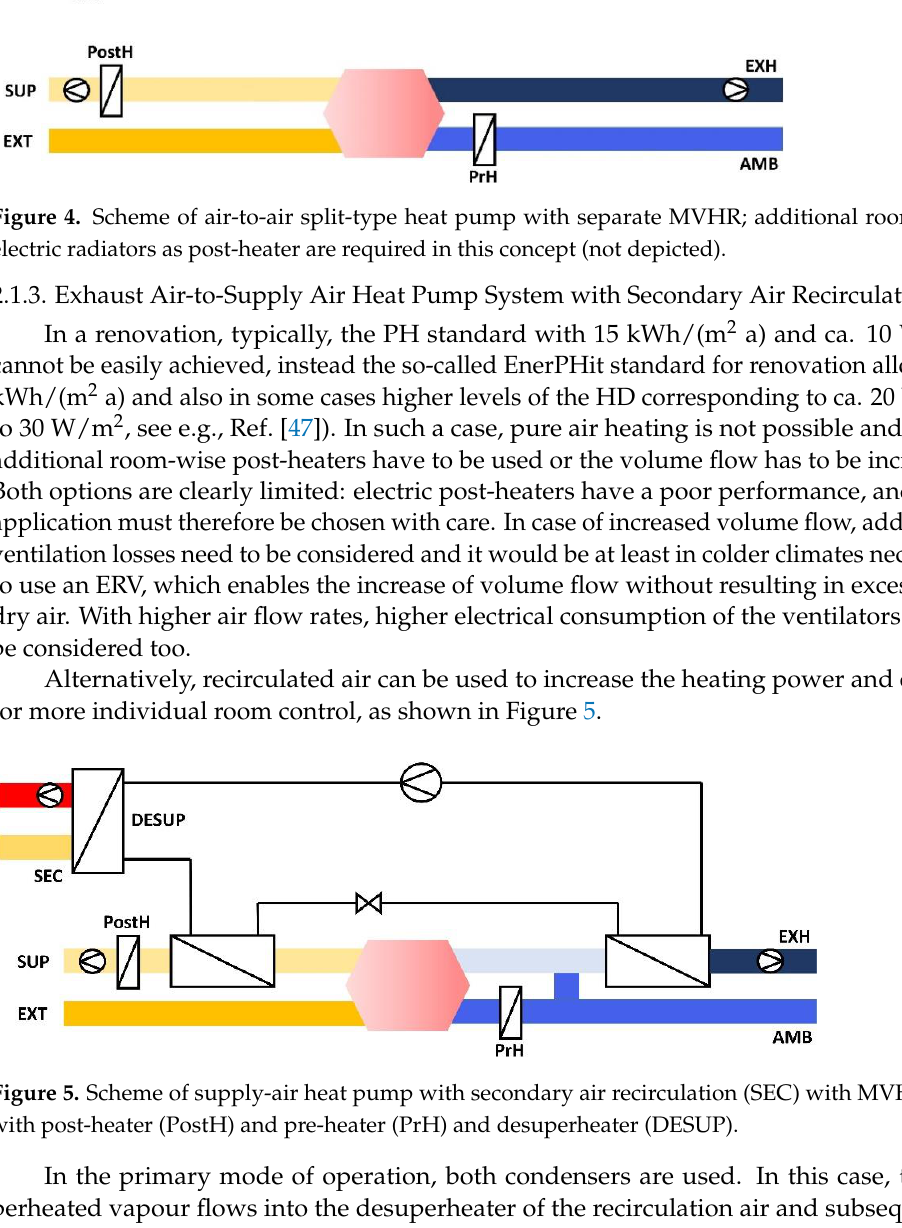
Figure 4. Scheme of air-to-air split-type heat pump with separate MVHR; additional room-wise electric radiators as post-heater are required in this concept (not depicted).